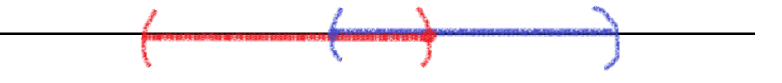
Figure 4. Linked